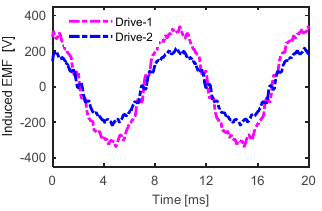
Figure 18. Induced EMF at optimal current angle and rated condition.